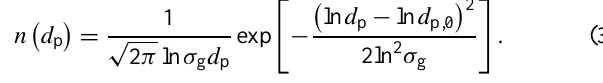
with phase functions 11